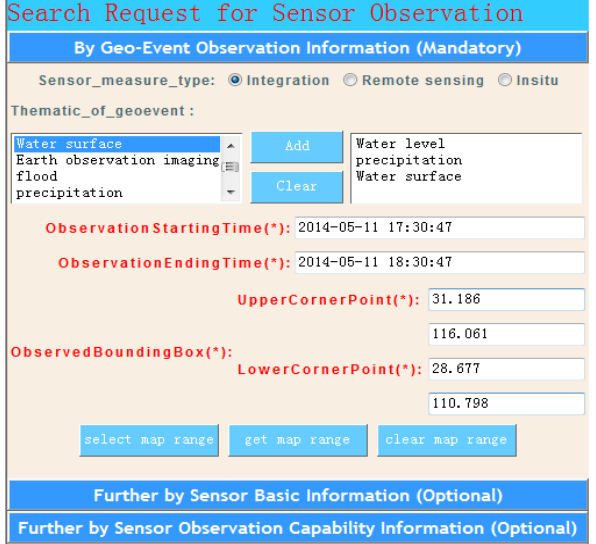
Figure 8. Search request by combining observation capability